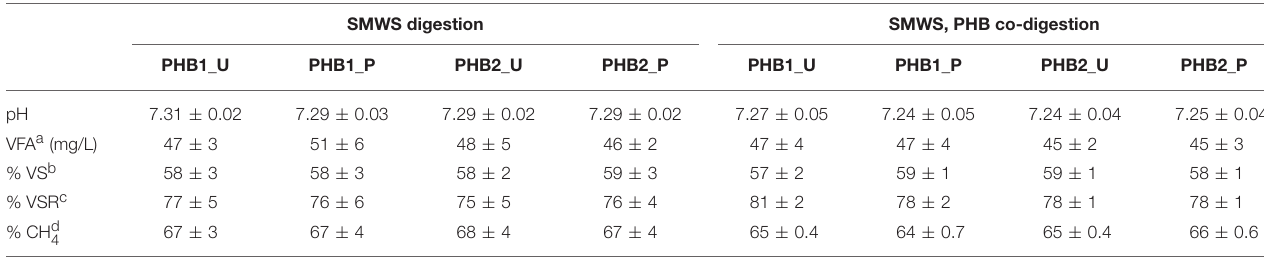
TABLE 2 | Bench scale digestion meta data, (U, untreated; P, pretreated). SMWS digestion SMWS, PHB co-digestion